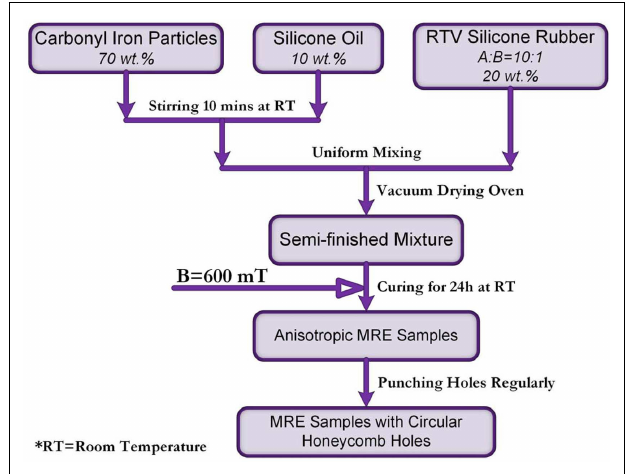
Table 1 | Specification of the prepared MRE samples